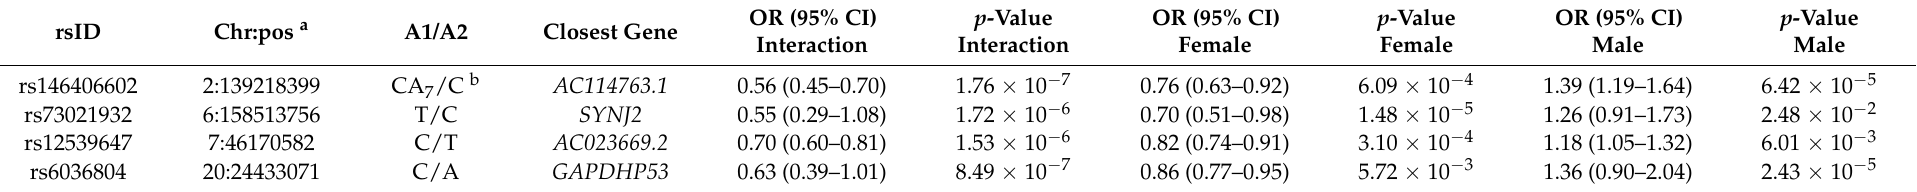
Table 2. Summary of independent suggestive variants identified ( p -value < 1.9 × 10 − 6 ) in the interaction GWAS and their association results in stratified analyses.